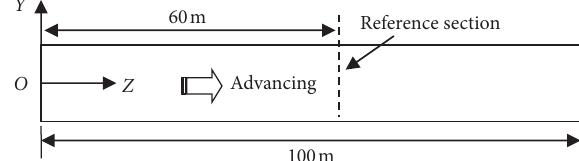
Figure 2: Schematic advancing of the tunnel face.